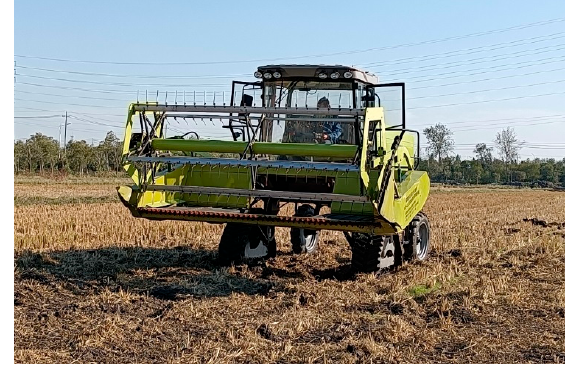
Figure 19. Running on rice stubble field.